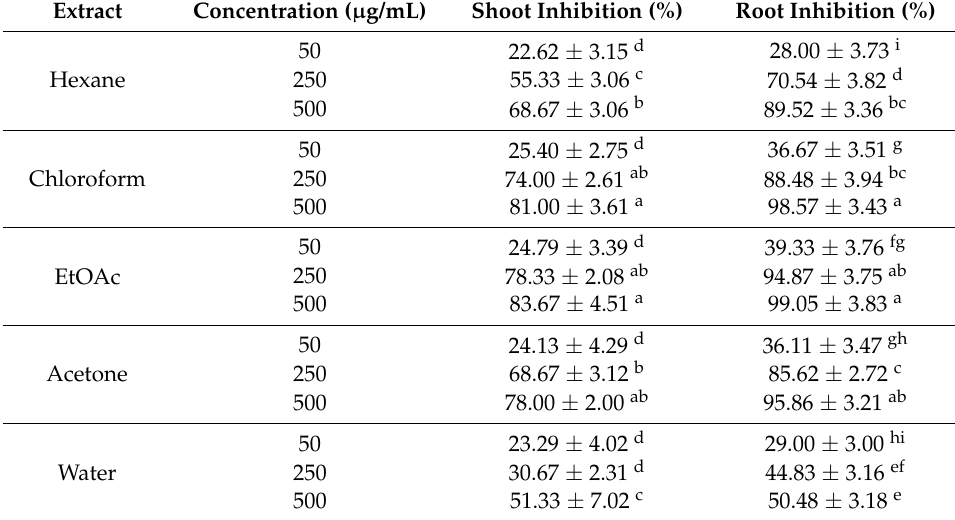
Table 1. Effect of different extracts of Piper methysticum root on growth of R. sativus